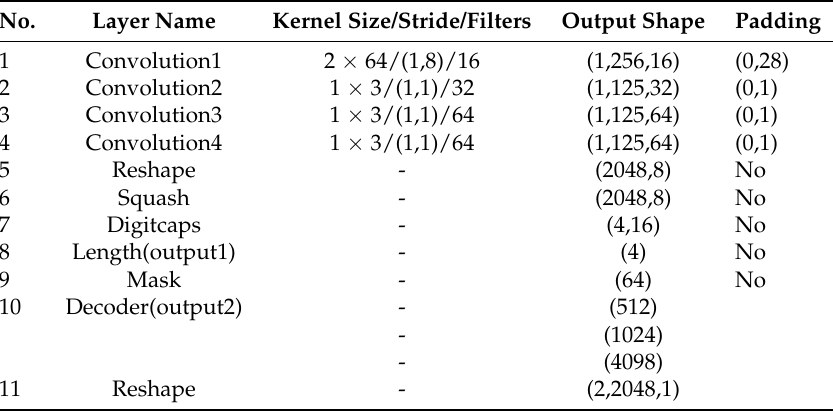
Table 2. Details of the proposed